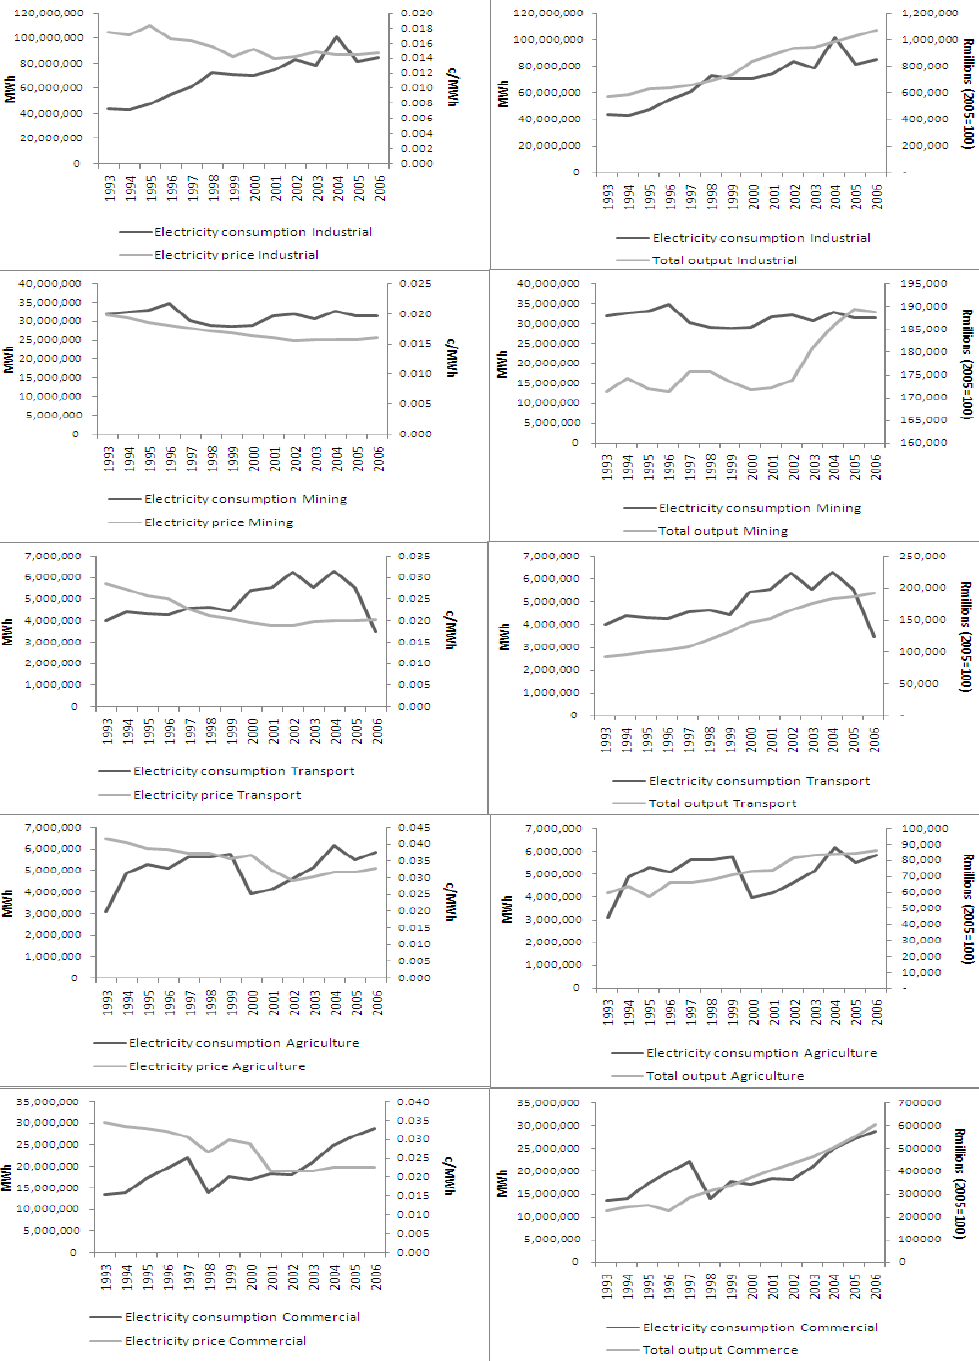
Electricity consumption, prices and economic output for the Industrial, Mining, Transport, Agriculture and Commercial sectors for the period 1993 to